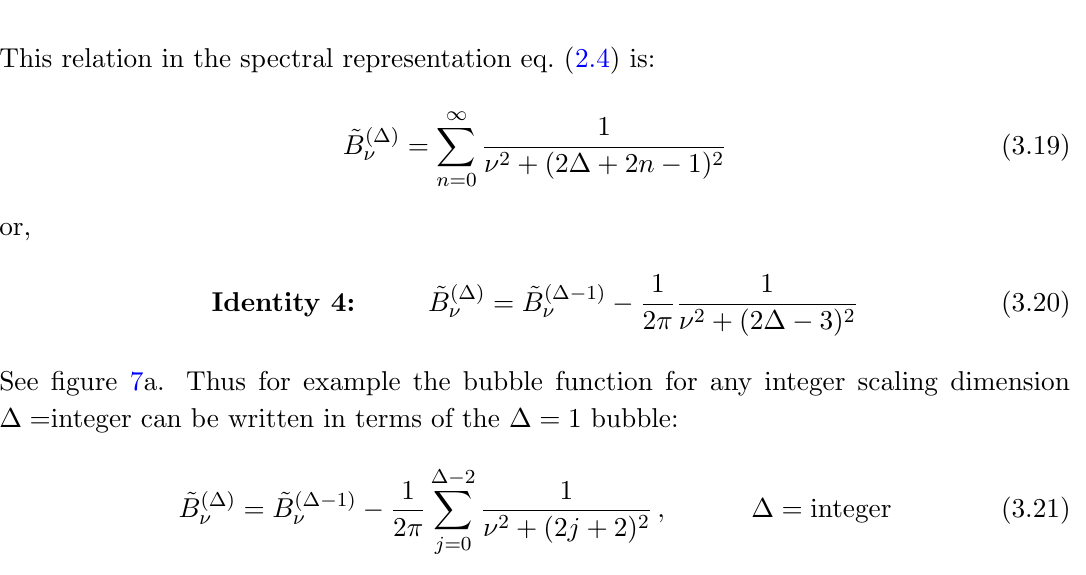
Figure 7 . a) Identity 4: The 1-loop bubble with scaling dimension (cid:1) is simply related to the bubble with scaling dimension (cid:1) (cid:0) 1. b) Identity 5’: The two-loop bubble on the left equals a 1-loop bubble plus a propagator. c) Identity 5. Identities 5 and 5’ enable to reduce an M bubble diagram to an M (cid:0) 1 bubble diagram. We are suppressing numerical coe(cid:14)cients in these